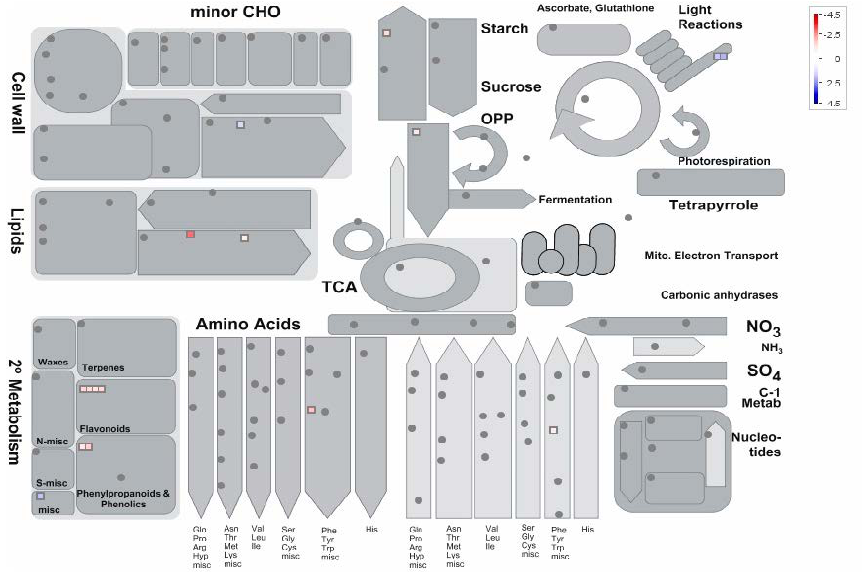
Figure 6. Differentially expressed gene function enrichment analysis under non-stress conditions.